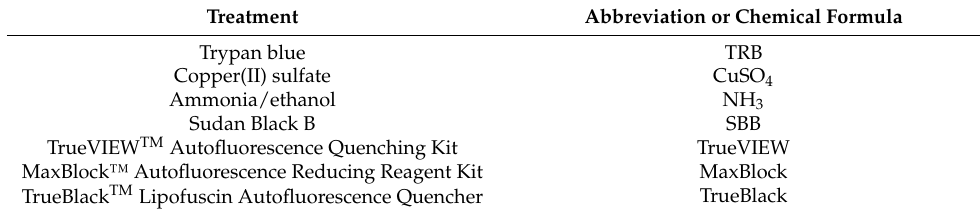
Table 1. Summary of Autofluorescence